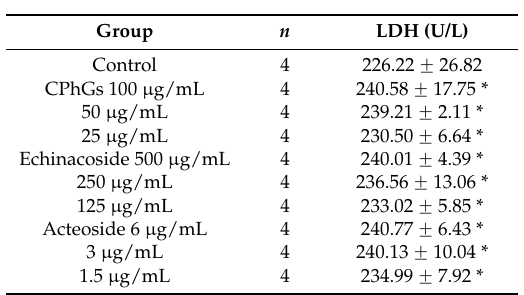
Table 2. Influence of CPhGs, echinacoside and acteoside on LDH secretion in